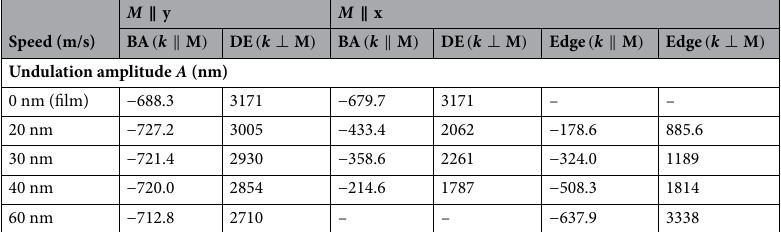
Table 2. Values of the average group velocity (m/s) of the spin wave propagating along either coordinates, for the two magnetic configurations. As explained in the article body, the largest value is got by an edge mode, surprisingly. In configuration M (cid:31) x no bulk cell function is found. The negative sign in the values indicates the negative slope of the dispersion (BA